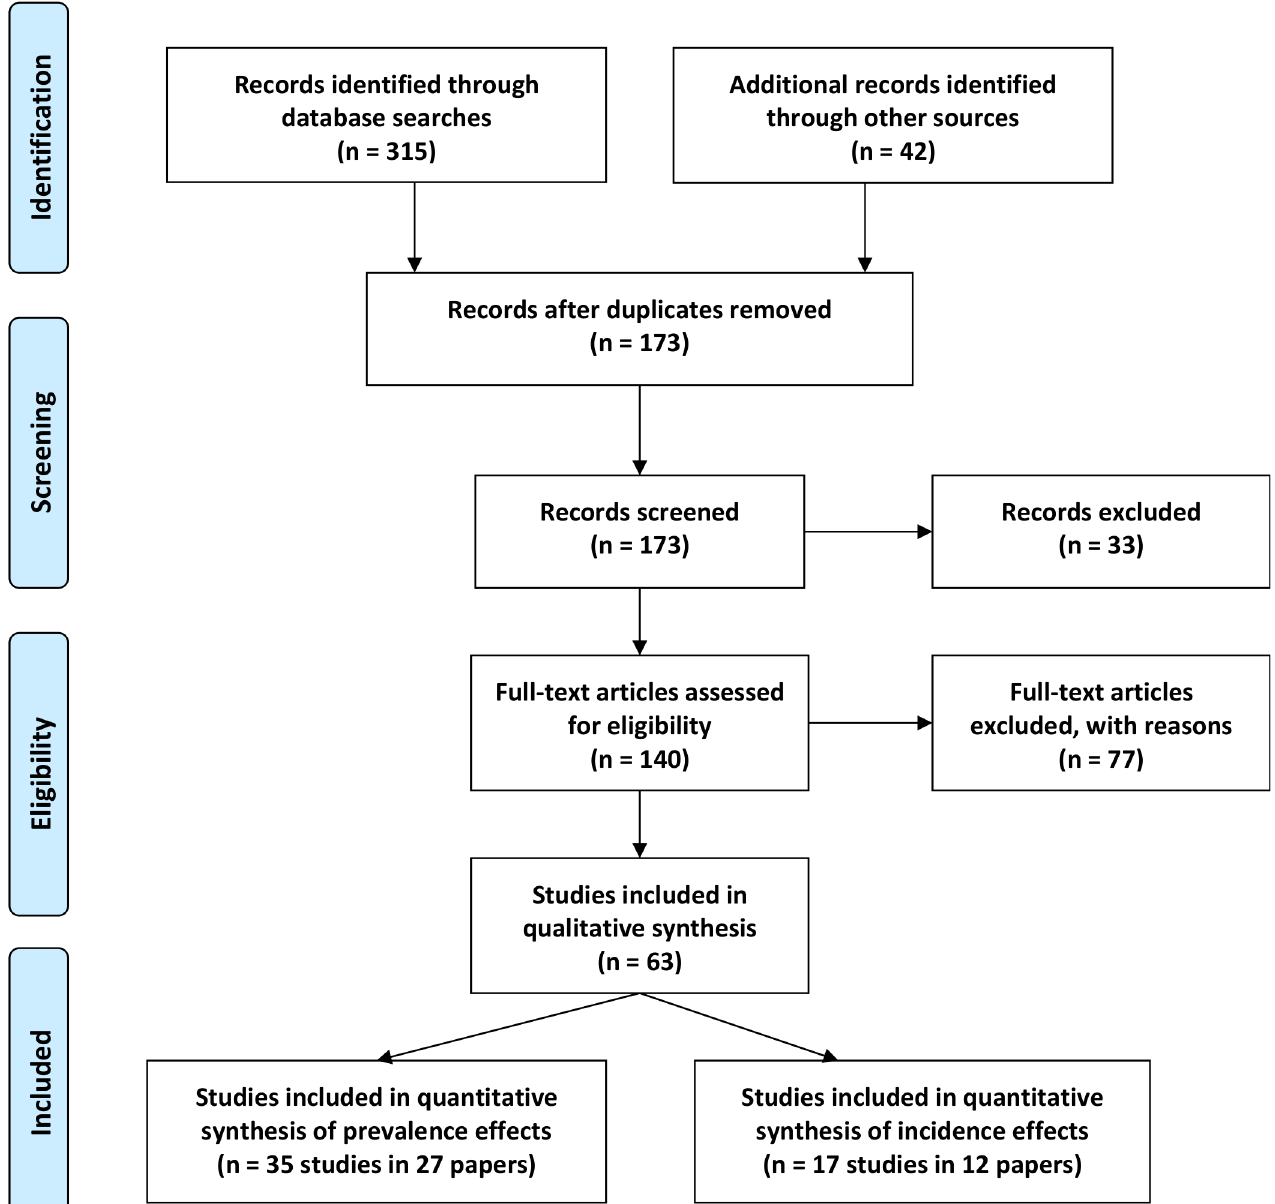
Fig 1. Flow chart for study selection. The flow diagram indicates the numbers of titles and studies reviewed in preparation of the current systematic review and meta-analysis of chemical mollusciciding effects on Biomphalaria and Bulinus spp. in Schistosoma -endemic areas.